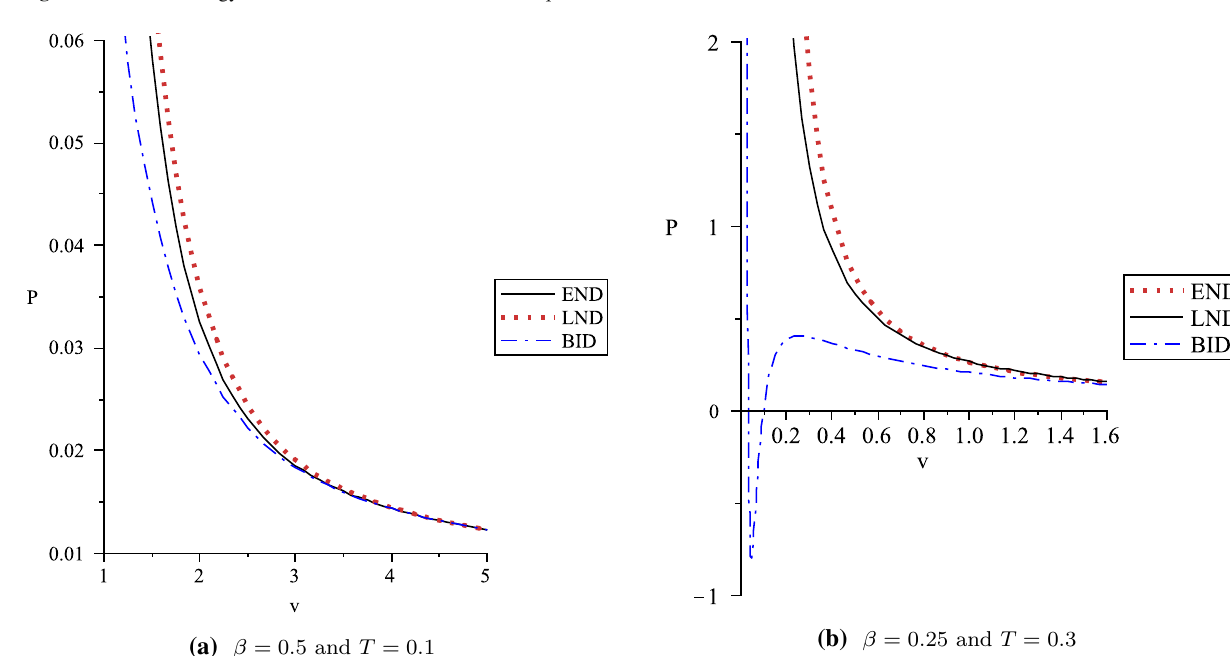
Fig. 7 Gibbs free energy versus T of dilaton black holes for q = b = k = 1 and α = 0 . 2